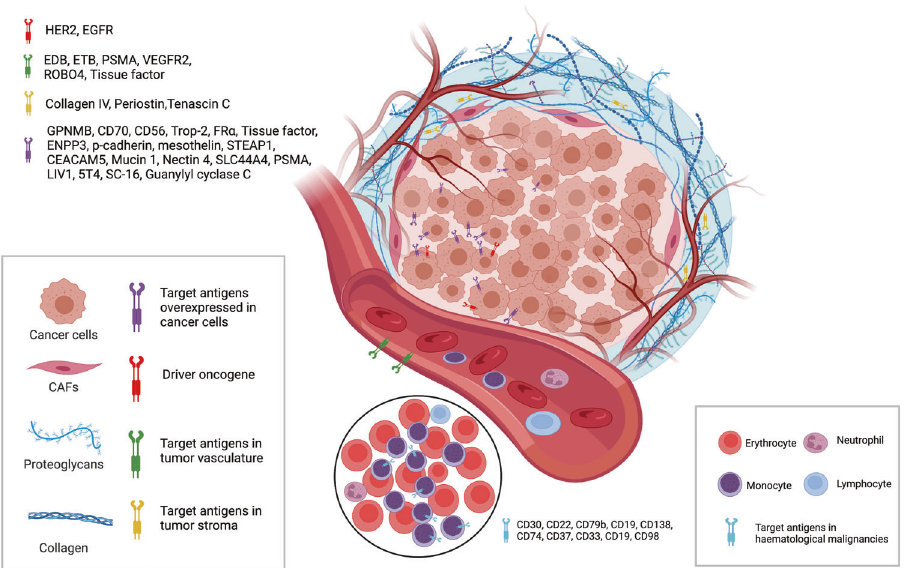
Fig. 3 The important target antigens from tumor cells (overexpressed and driver genes) and tumor microenvironment (vasculature and stroma) are used for the development of ADC. Created with